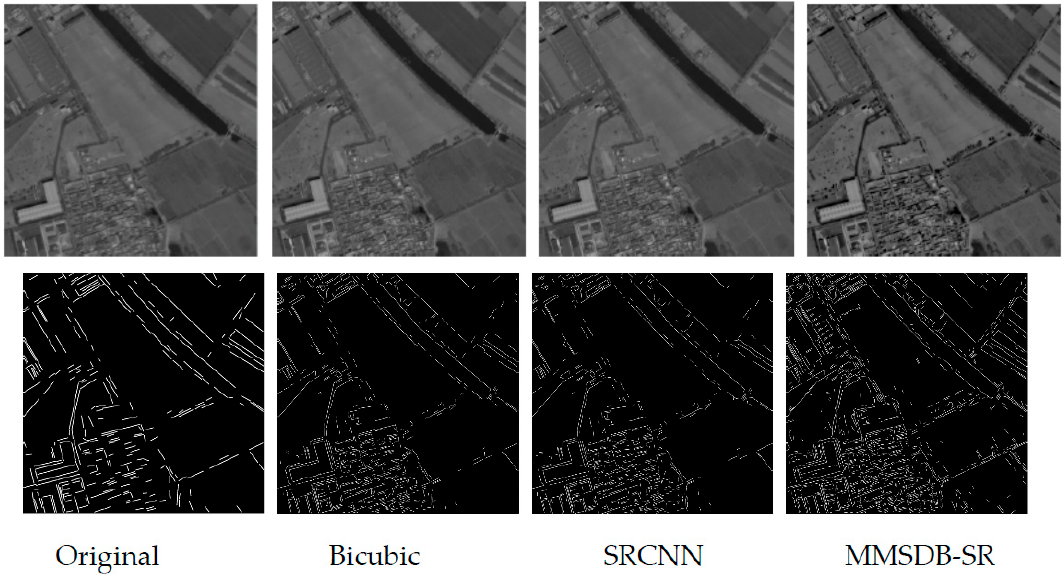
Figure 10. Feature-line-extraction results.